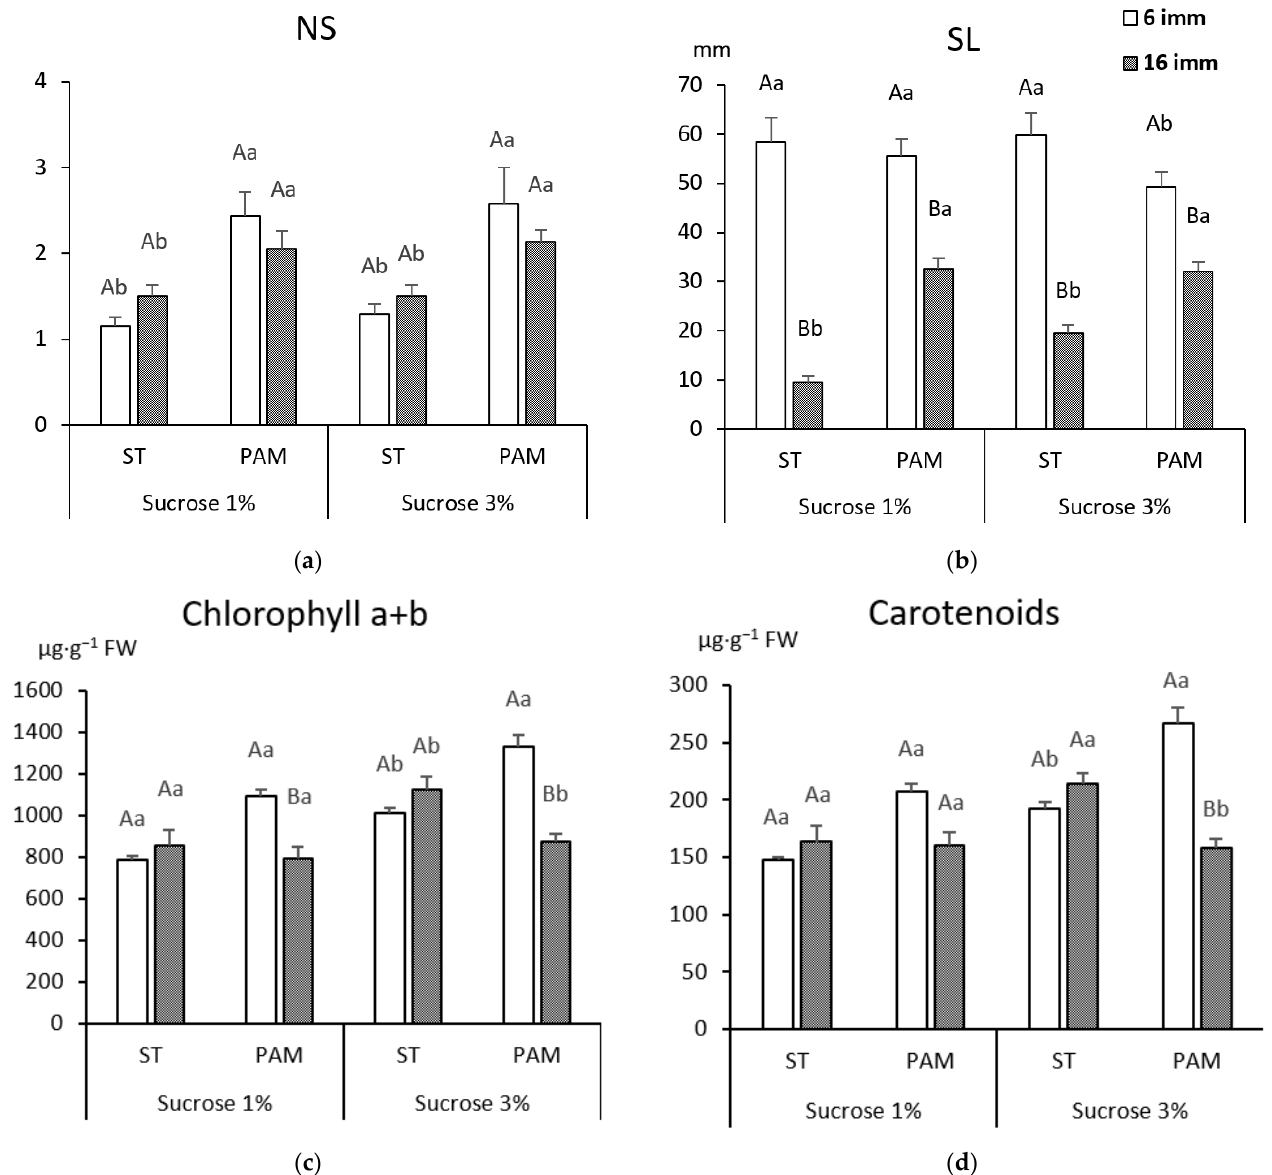
Figure 2. Effect of sucrose supplementation, immersion frequency (6 or 16 immersion/day) and growth conditions (standard or PAM) on proliferation rates ( a , b ) and pigment content ( c , d ) of apical sections of willow shoots cultured in RITA ® vessels. Values are the mean ± standard error from two replicate trials each with 2 RITA ® vessels. For each sucrose supplementation and variable, different capital letters indicate significant differences ( p < 0.05) in relation to the frequency of immersion, and different lowercase letters indicate significant differences in relation to growth conditions (standard or PAM). Due to the significant interaction found in SL and pigments, Bonferroni’s adjustment was applied to detect simple main effects. FW Fresh weight, NS number of shoots per explant, SL length of the longest shoot, ST standard conditions, PAM high PPF + CO 2 -enriched air.